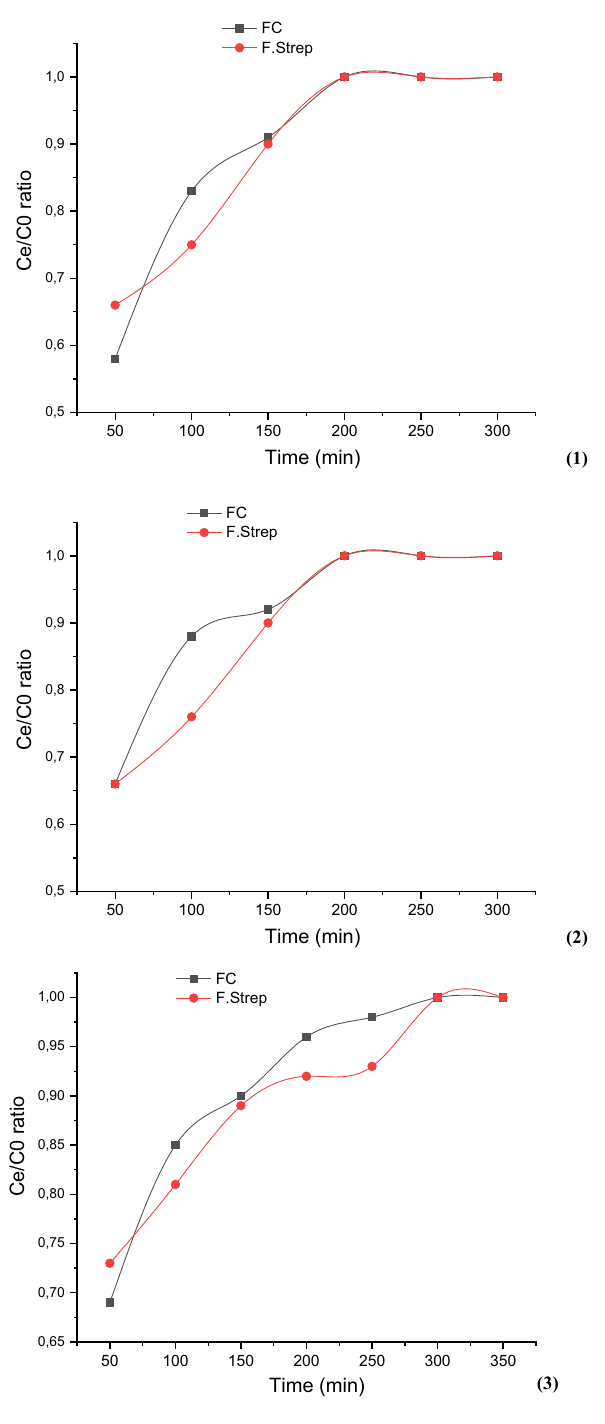
Fig. 8 Breakthrough curves for the adsorption of thermotolerant coliforms and fecal streptococci. (1): DE sample 1; (2): DE sample 2; (3): DE sample 3; DE: Dairy effluents; FC: Thermotolerant coli- forms; F. Strep: Fecal